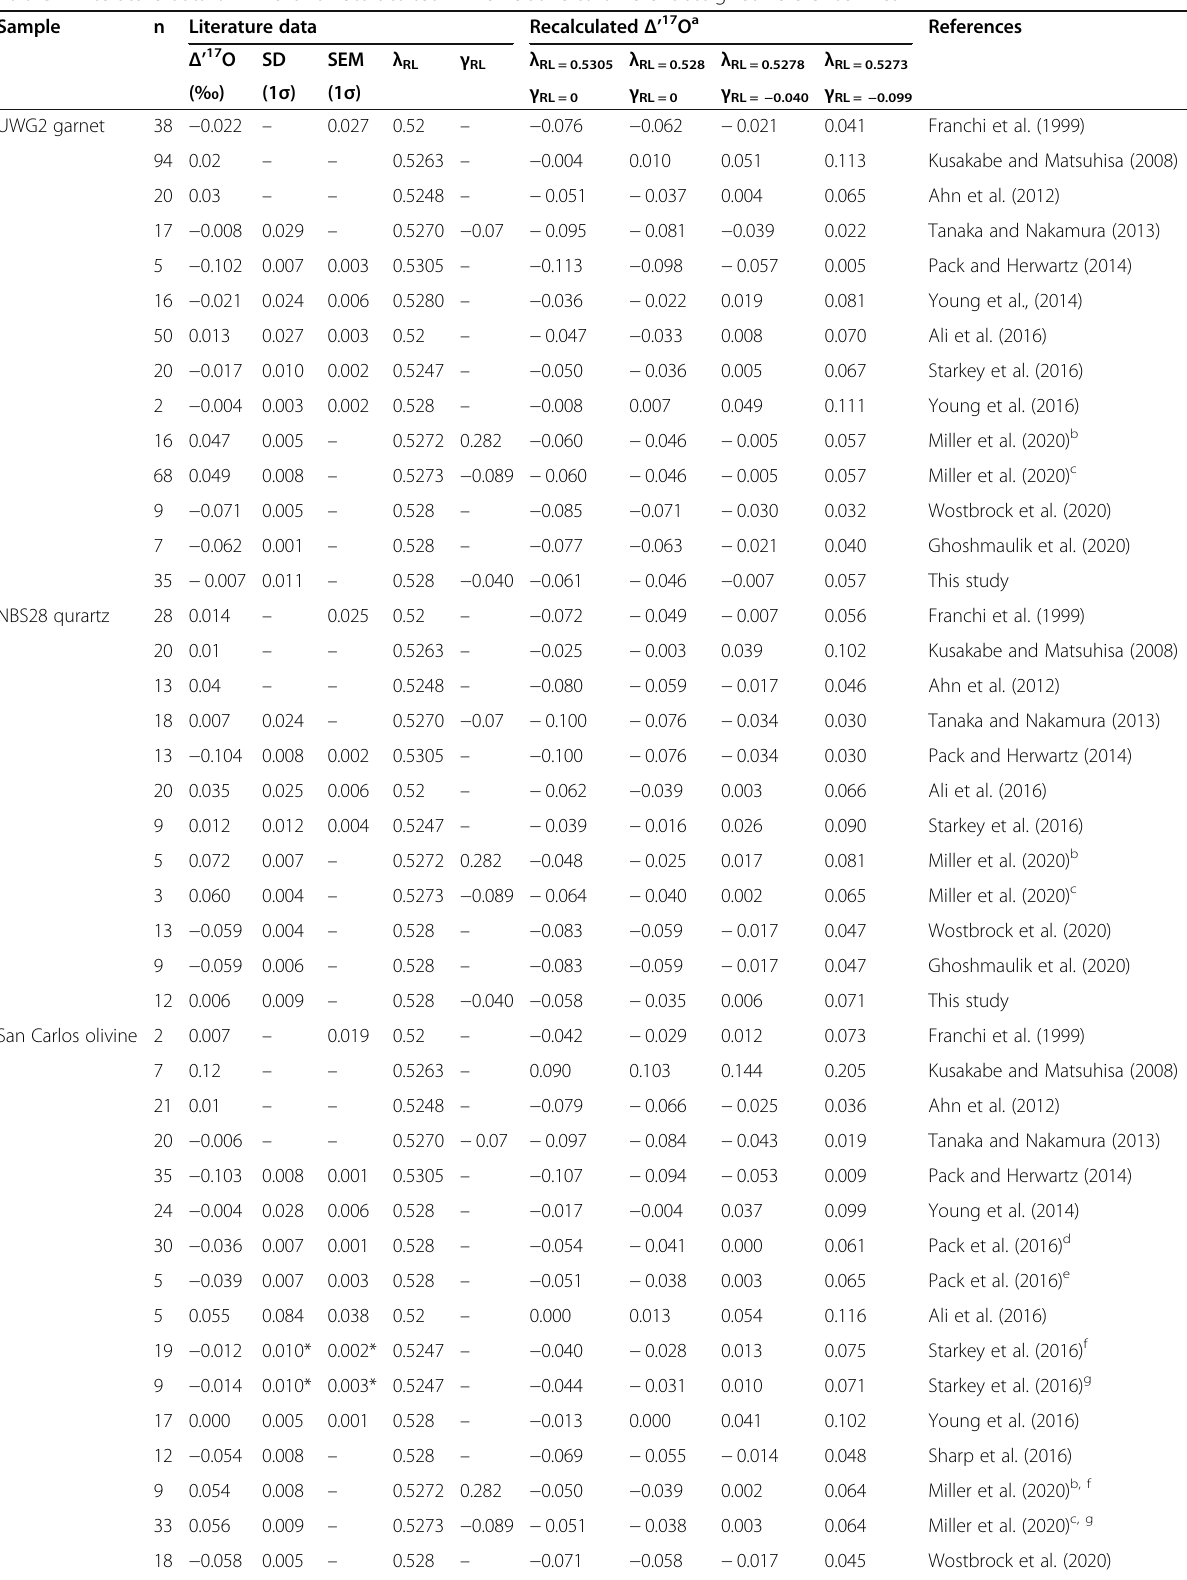
Table 4 Literature data of Δ 17 O and recalucalted Δ ’ 17 O relative to different assigned reference lines Sample